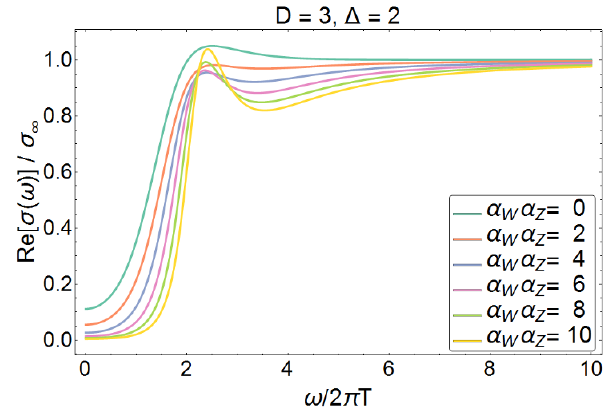
Figure 9 . The real part of the conductivity for D = 3, (cid:1) = 2 and ‘charge parameter’ (cid:24) = 1 for various values of (cid:11) Z (cid:11) W . Coupling to the relevant operator leads to pronounced features in Re( (cid:27) ) O at intermediate frequencies, in addition to modifying the high frequency asymptotics as in (5.26). Here (cid:15) is the energy density and P is the pressure. A uniform and static electric (cid:12)eld can impart momentum into a system at (cid:12)nite charge density at a (cid:12)xed rate via the Lorentz force: this is the origin of this (cid:14) function. This (cid:14) function must be taken into account when evaluating sum rules, and upon doing so, the sum rules for the conductivity are